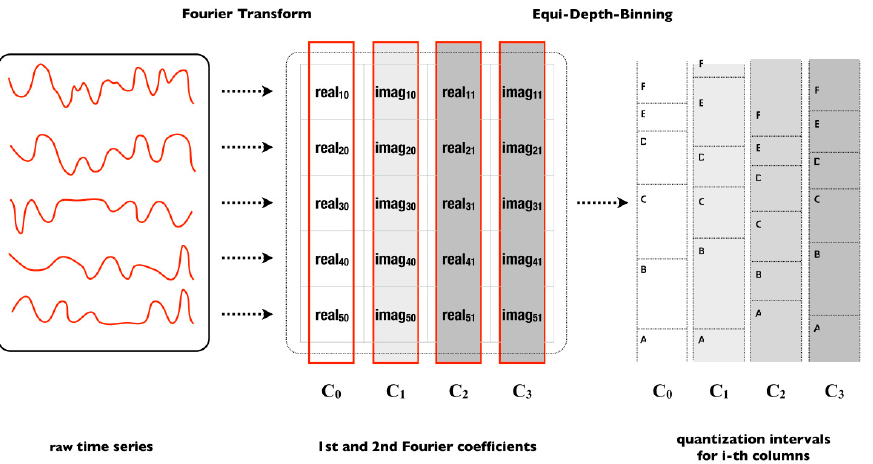
Figure 7. Example of generation of the MCB by means of the coefficients of the MFT [29].